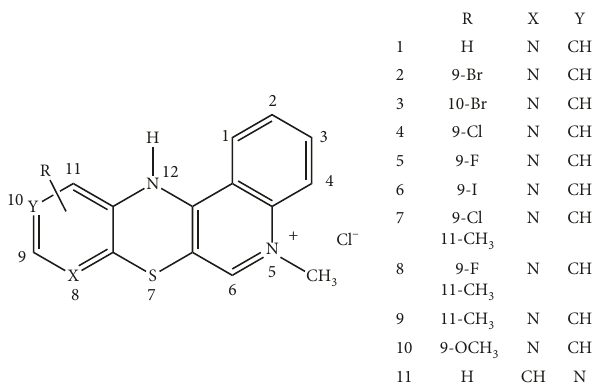
Figure 1: General structure of pyridoquinothiazine derivatives investigated ( 1 – 11